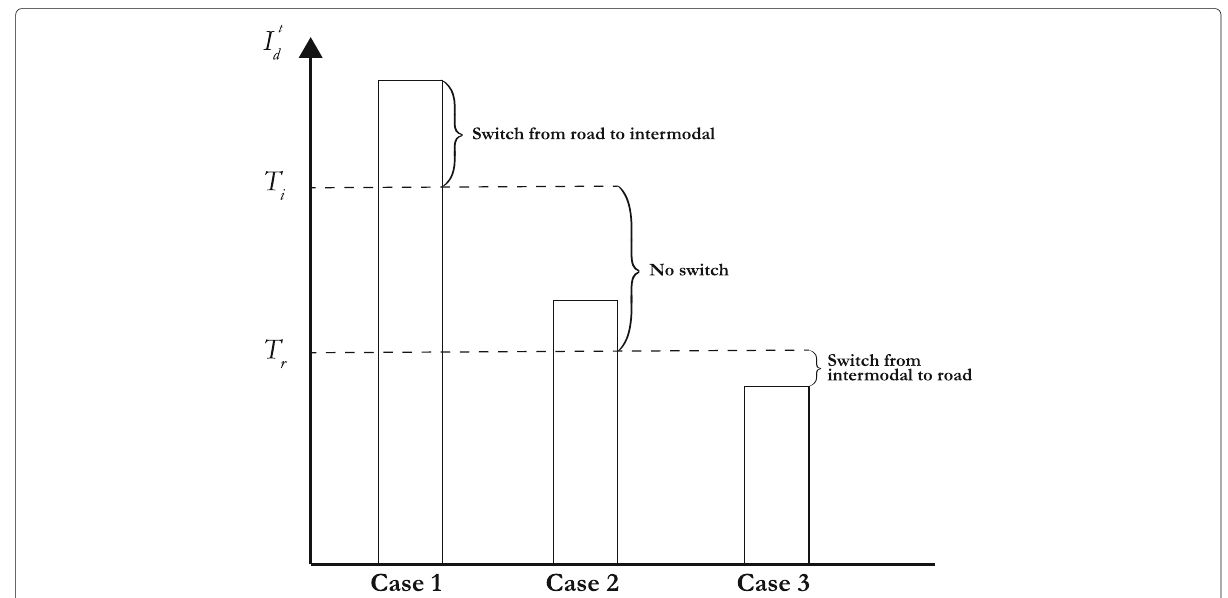
t − L r > T ( I t − T ) units of the order will be slowed down and shipped via intermodal transport (the shifted volume is Fig. 4 When I t i (case 1), min i , Q r d d bounded by the number of units arriving at the terminal, Q t − L r r ); when T r ≤ I t